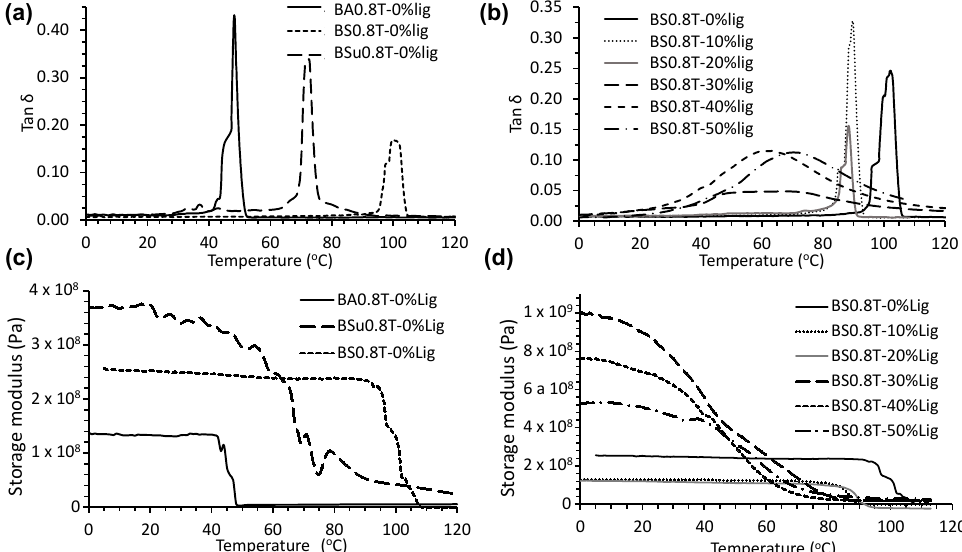
Figure 6. DMA tan δ thermograms of ( a ) polymers BA0.8T, BS0.8T and BSu0.8T, ( b ) BS0.8T-0 − 50%lignin copolymers, and storage modulus thermograms of ( c ) polymers BA0.8T, BS0.8T and BSu0.8T, and ( d ) BS0.8T-0 − 50%lignin copolymers. Table 5. Melt transitions (T m ) and storage modulus (E’) at 15 °C for the various lignin-copolymers determined by DMA. Lignin Content (%)